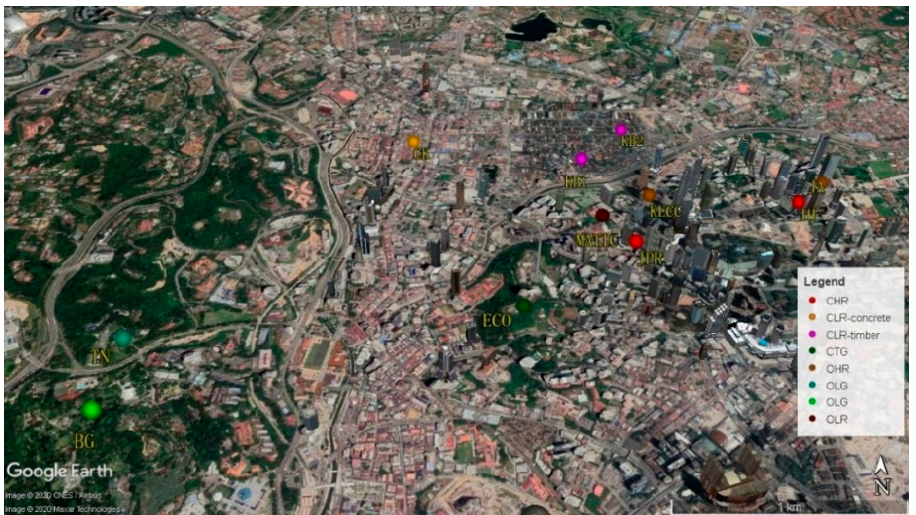
Figure 2. T and RH monitoring locations in Kuala Lumpur city center (drawn on Google Earth).